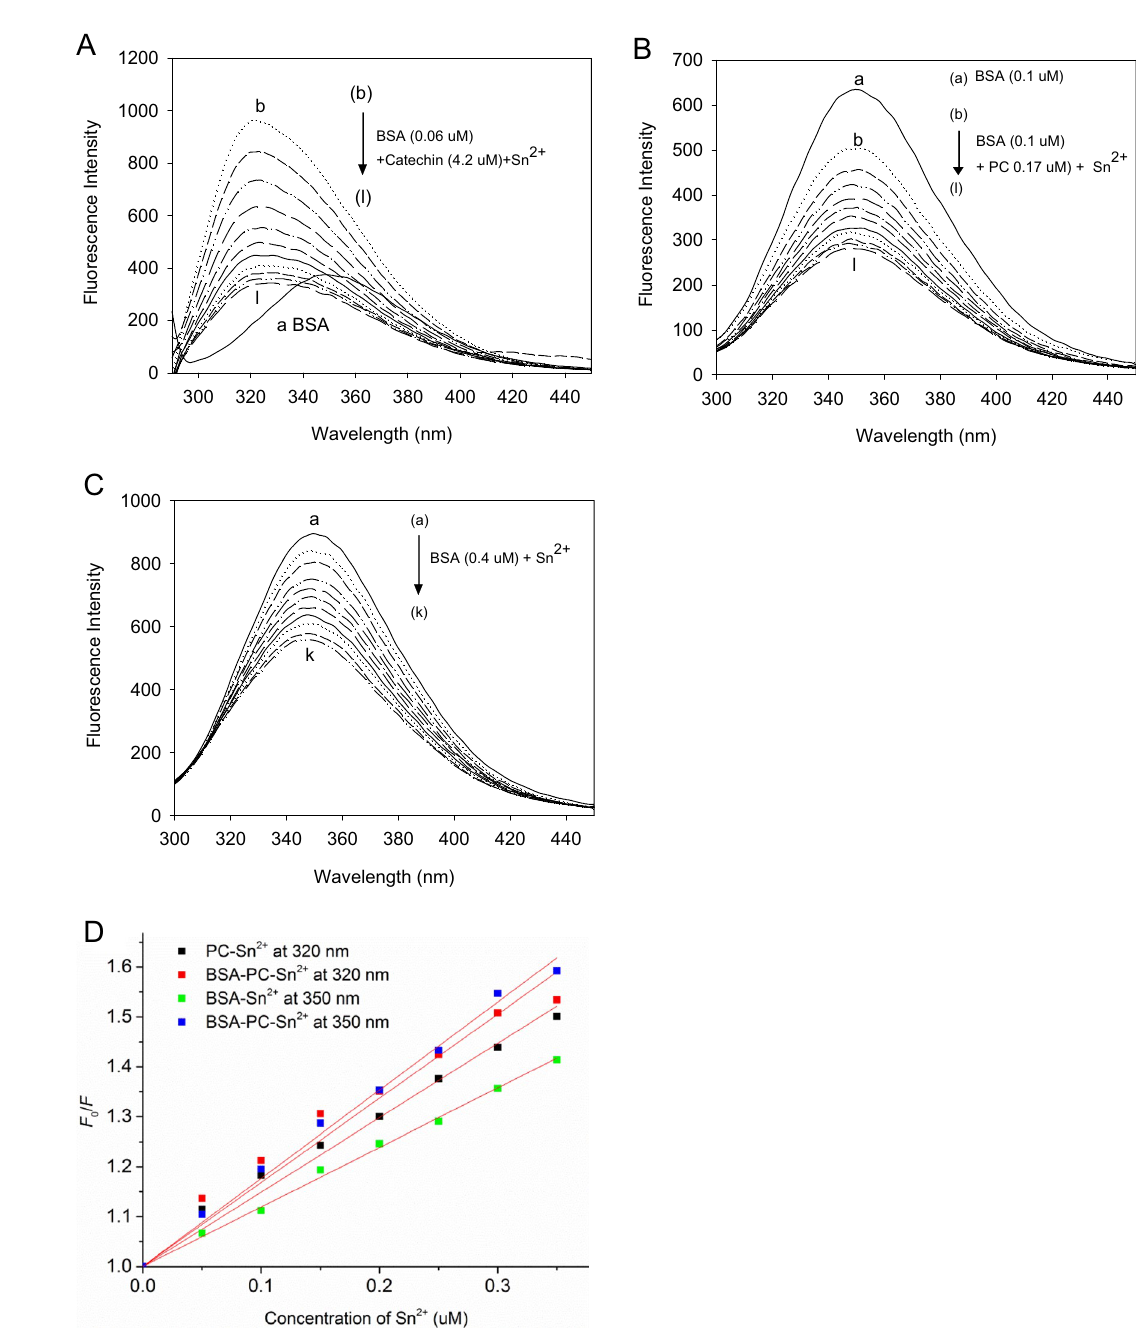
Figure 5. The fluorescence quenching spectrum of ( A ) catechin and ( B ) PC at various concentrations of Sn 2+ in the presence of BSA; ( C ) The fluorescence quenching spectrum of BSA with Sn 2+ . λ ex , 280 nm; c (Sn 2+ ) ( A ) (b → l), 0.0, 0.4, 0.8, 1.2, 1.6, 2.0, 2.4, 2.8, 3.2, 3.6, 4.0 μM; c (Sn 2+ ) ( B ) (b → l), 0.0, 0.05, 0.1, 0.15, 0.2, 0.25, 0.3, 0.35, 0.4, 0.45, 0.5 μM; c (Sn 2+ ) ( C ) (a → k), 0.0, 0.05, 0.1, 0.15, 0.2, 0.25, 0.3, 0.35, 0.4, 0.45, 0.5 μM; ( D ) the Stern–Volmer plots for PC and BSA-PC mixture fluorescence quenching by Sn 2+ at 320 nm, and BSA and BSA-PC mixture fluorescence quenching by Sn 2+ at 350 nm. λ ex , 280 nm; c (PC), 1.67 μM; c (BSA), 0.4 μM; BSA (0.1 μM) plus PC (0.17